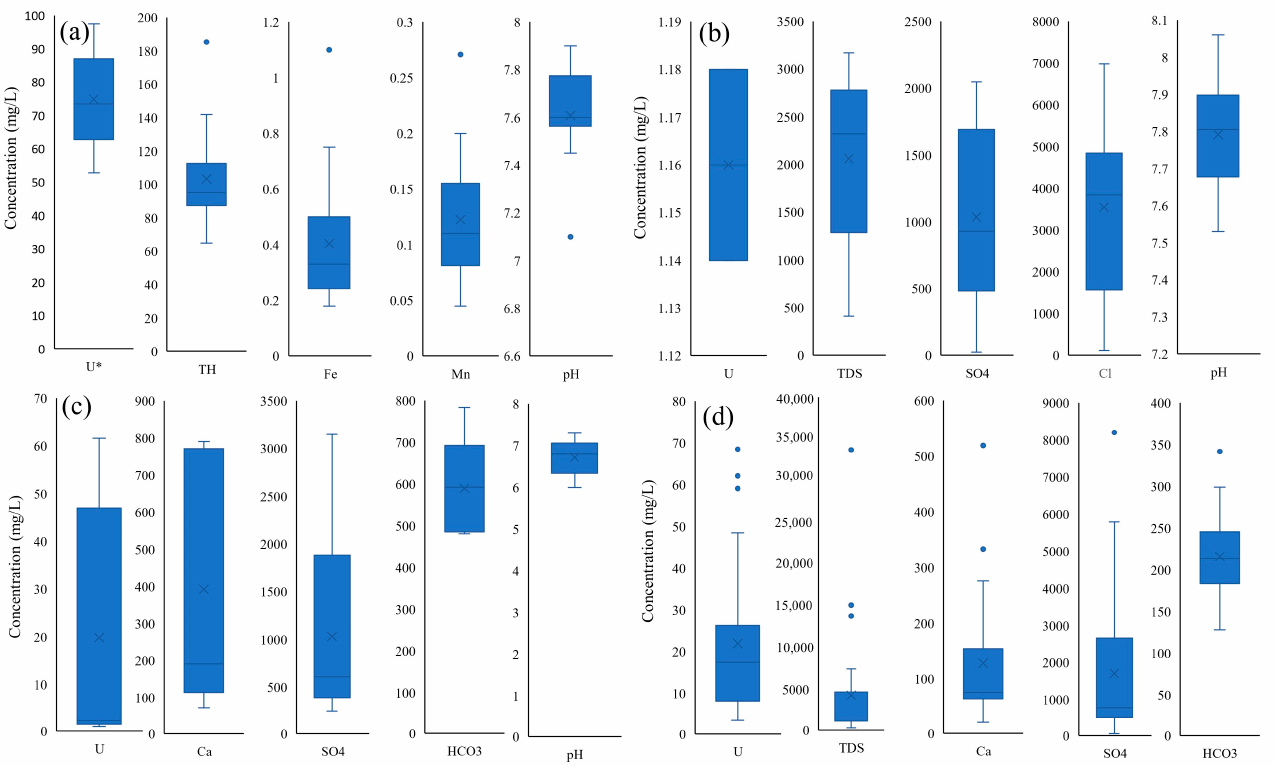
Figure 5. Representative constant elements of groundwater in the ore belt ( a ) for the Songliao Basin; ( b ) for the Ordos Basin; ( c ) for the Turpan-Hami Basin; and ( d ) for the Ili Basin. The pH is unitless, and * represents µg/L [14,75,79–91].